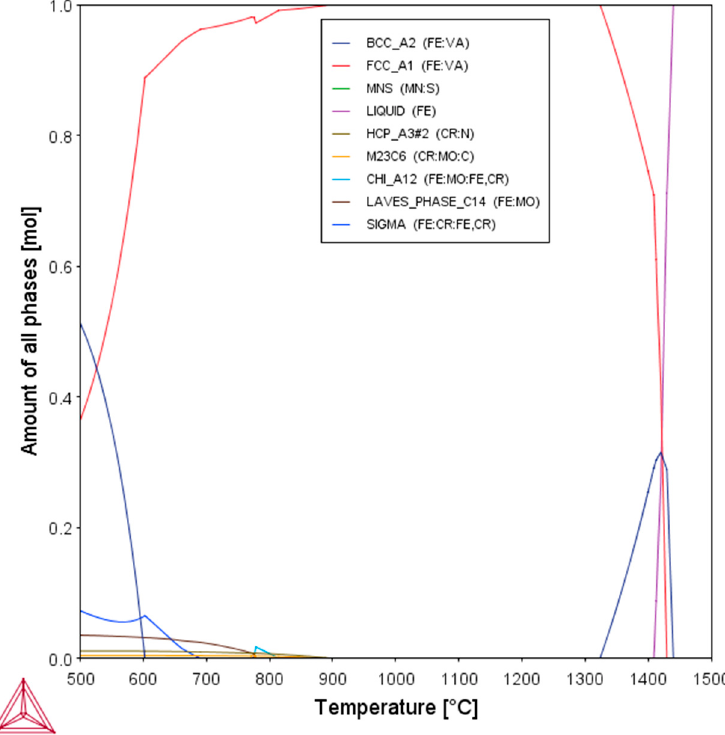
Figure 12. ThermoCalc prediction of equilibrium phases in SS316L as a function of temperature. BCC_A2 is the delta-ferrite phase. FCC_A1 is the austenite phase.